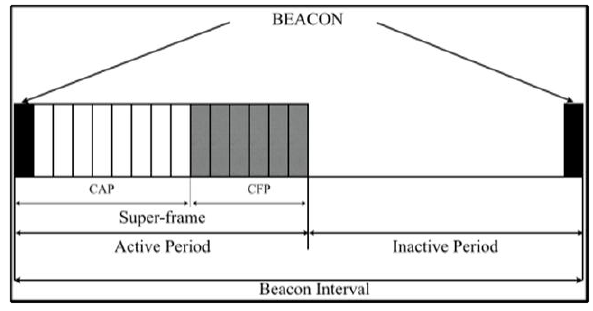
Figure 3. IEEE 802.15.4 Beacon Mode Frame